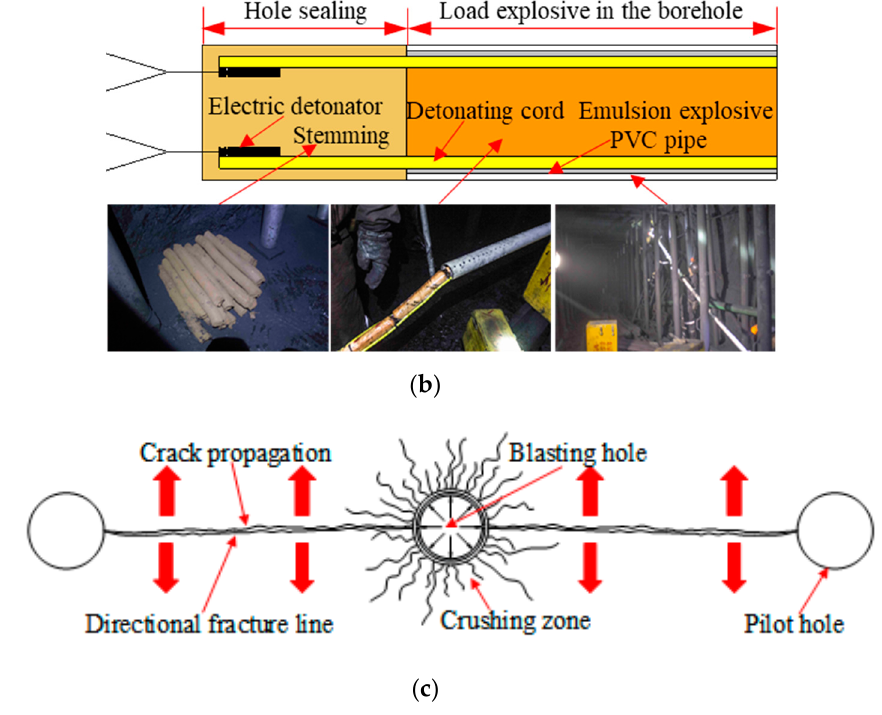
Figure 10. PVC pipe charging structure and directional fracture propagation: ( a ) PVC pipe size and perforation; ( b ) PVC pipe charging structure; ( c ) directional blasting fracture propagation.